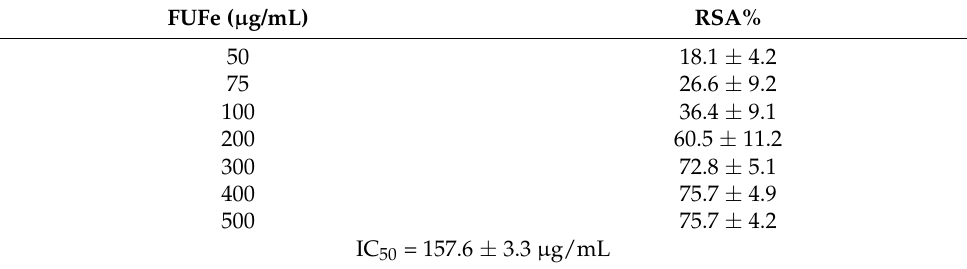
Table 2. Radical scavenging activity (%) of fucoidan extracted from F. hermonis (FUFe).